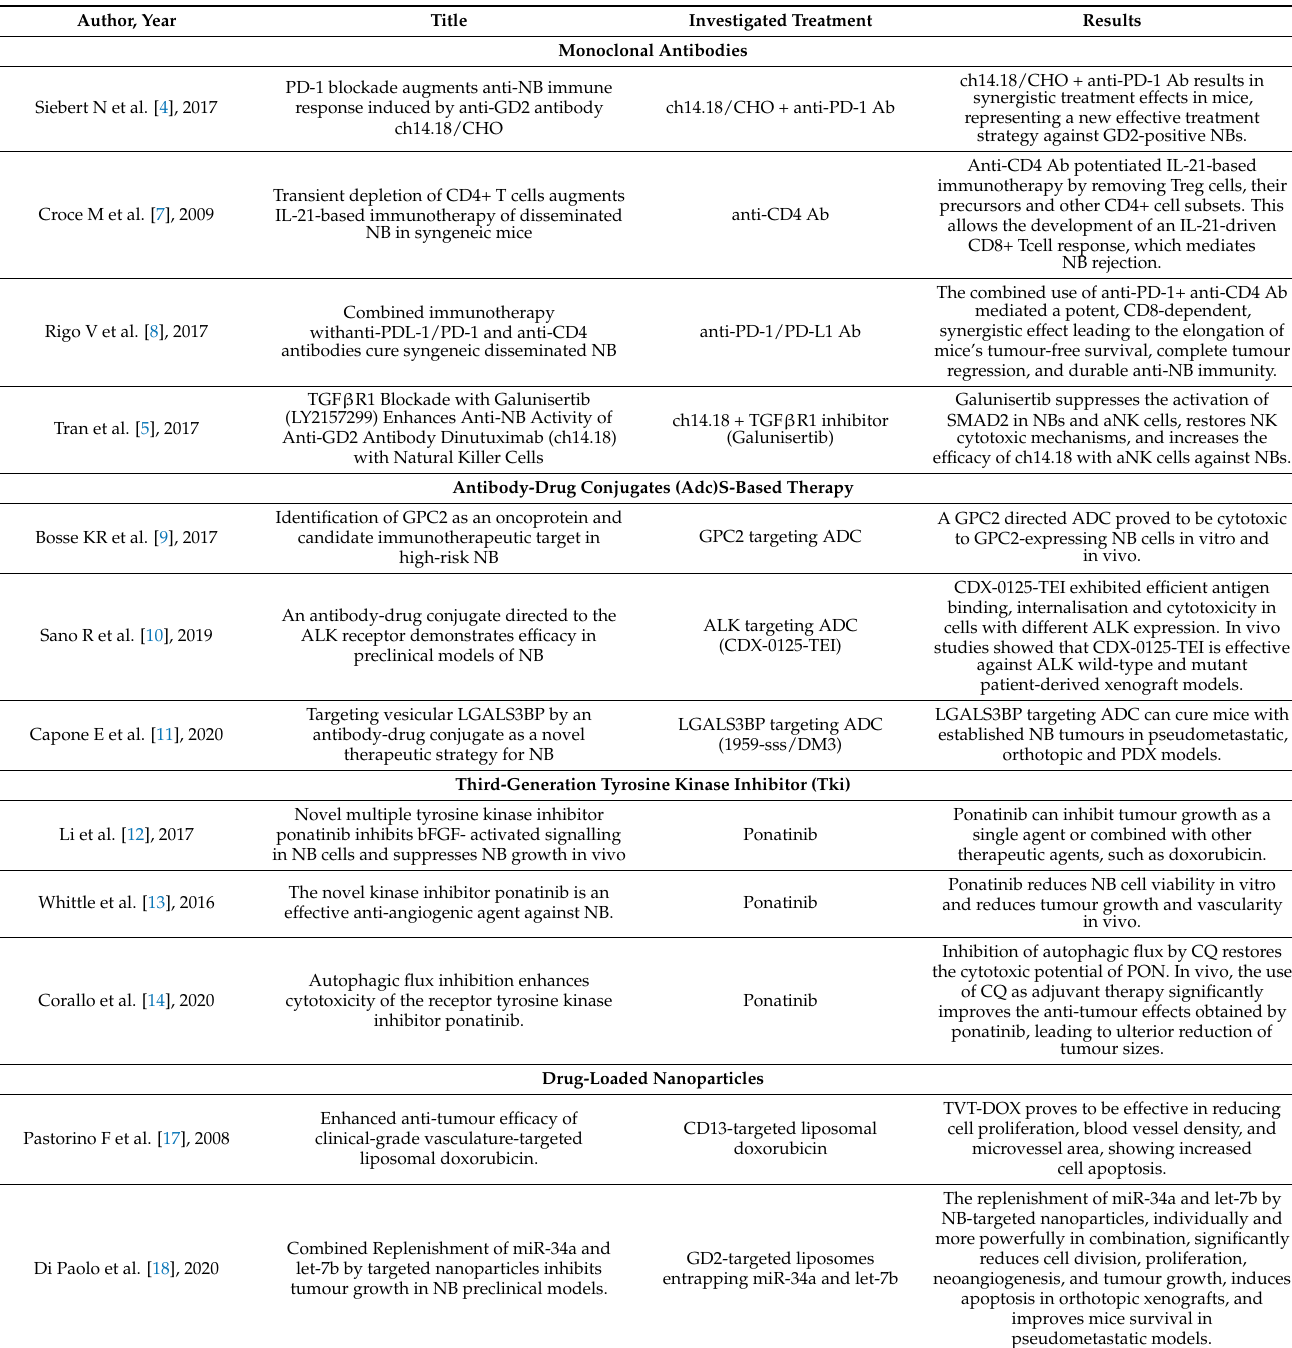
Table 1. Novel molecules and nanoparticles investigated in preclinical studies focusing on NB